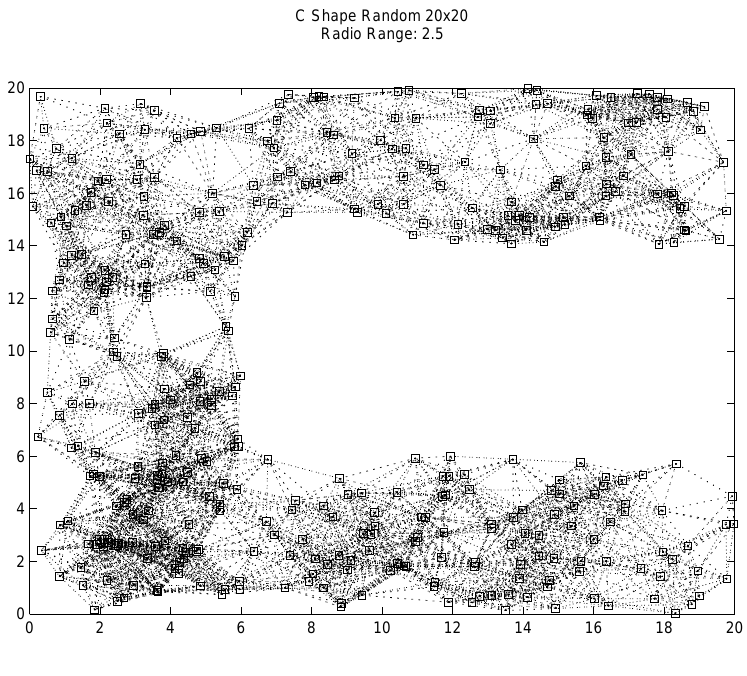
Figure 7. Anchor metrics for 10 random C-shape 20-by-20 unit networks with 400 nodes, 5,000 anchor sets each, and a radio range of 2.5 units. ( a ) Sum of distance between anchors vs . mean localization error, excluding outliers; ( b ) Minimum height of anchor triangle vs . mean localization